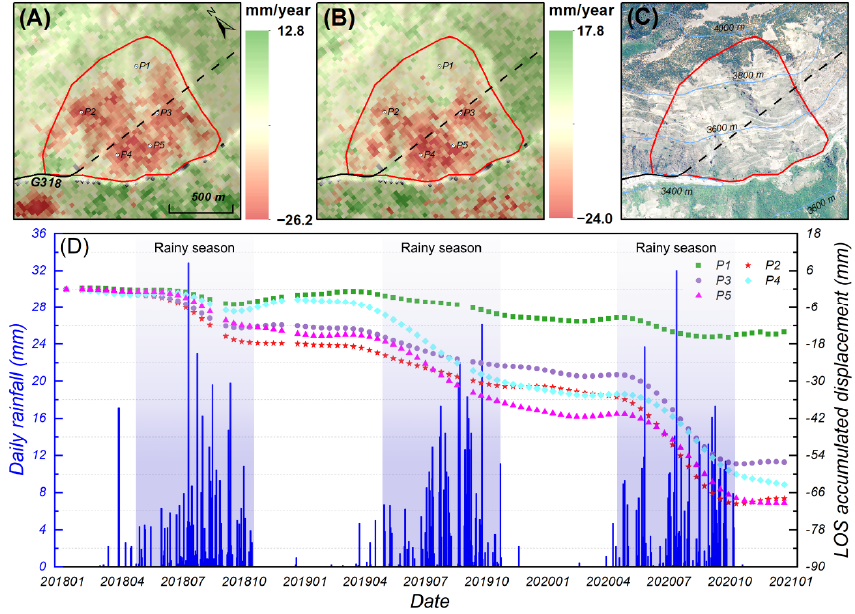
Figure 9. Landslide monitoring and analysis. ( A , B ) Vertical and horizontal deformation rate maps. The red line represents the landslide boundary, and the black dotted line represents the tunnel. ( C ) Tianditu image with a spatial resolution of 1 m. The blue lines represent the contour lines of the area. ( D ) LOS displacements of several points versus daily